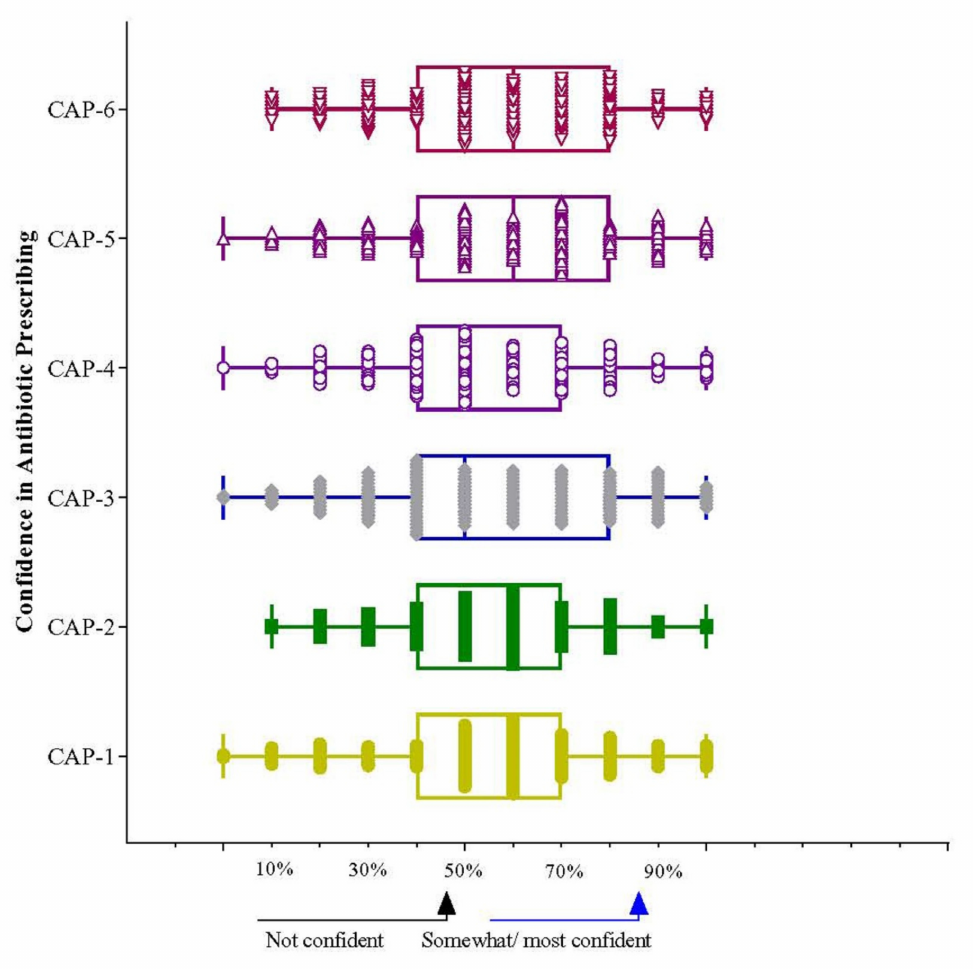
Figure 5. Scores of confidence in knowledge in different clinical situations. Data are presented as percentiles where <50% means not confident whereas >50–70% indicates somewhat and